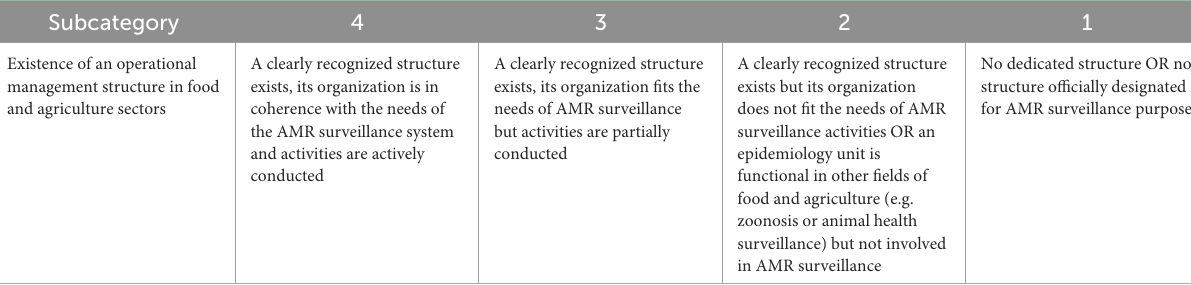
TABLE 3 Example of scoring with the semi-quantitative